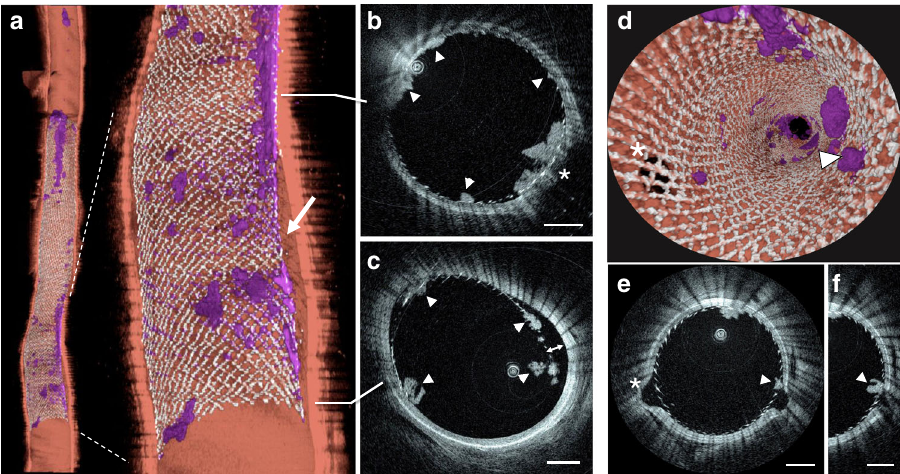
Fig. 3 HF-OCT volumetric rendering of a stented swine internal maxillary artery. a HF-OCT three-dimensional cutaway rendering (top = distal; bottom = proximal). Flow-diverter malapposition (arrow) and clots of different sizes (purple color) are visible over the fl ow-diverter surface. b Cross-sectional HF- OCT imaging show a jailed branch (asterisk) and several thrombus formations over the fl ow-diverter surface (arrowheads). c Flow-diverter proximal edge, with incomplete apposition (3 o ’ clock) and several clots over the device surface (arrowheads). d Endoscopic view of HF-OCT volumetric rendering. Small, perforator-like side-branches jailed by a fl ow-diverting stent are visible. e The side-branch located on the left side of the image (arrow) is free of clots and the fl ow-diverting stent is well-apposed to the parent artery. f A second branch located on the right (indicated by the asterisk) shows fl ow-diverter struts that are embedded by a clot. Stented arteries data collection was repeated in a total of n = 16 swine internal maxillary arteries, including n = 16 fl ow- diverting stents, and n = 15 self-expanding intracranial stents. Scale bars on all HF-OCT images are equal to 1 mm. Three-dimensional rendering color scheme: red, artery wall; purple, clot; silver, metallic